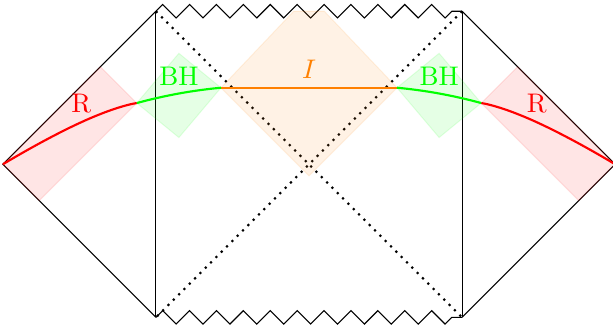
Figure 1 . The Penrose diagram of an AdS black hole coupled to the non-gravitating external bath. We take the radiation region R (red solid line) in the non-gravitating external bath. After the Page time, the island region I (orange solid line) becomes non-empty, and the entanglement wedge of the black hole BH is outside the horizon of the black hole (green shaded